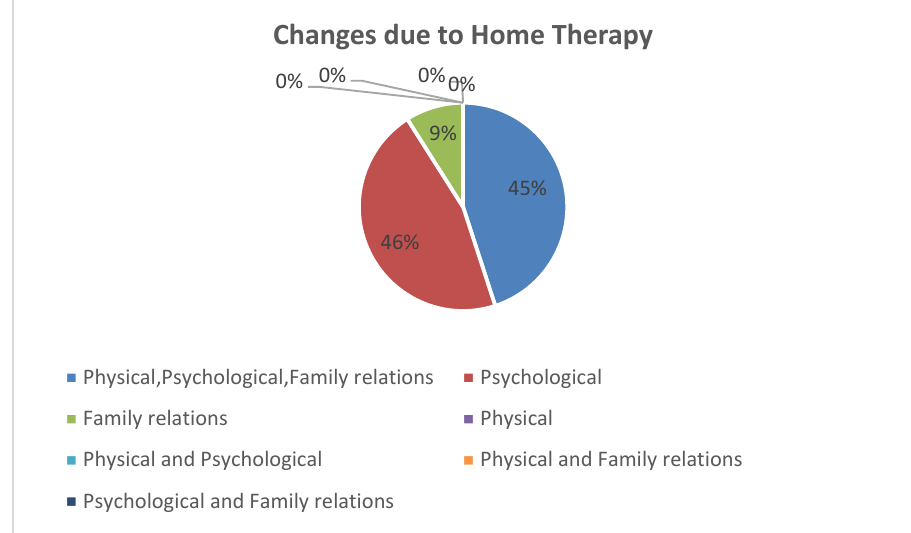
Figure 1. Reported changes related to home therapy in the study patients